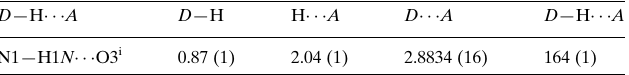
Hydrogen-bond geometry (A˚ , (cid:2)